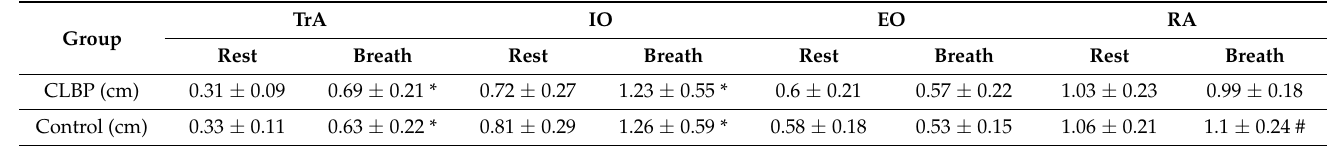
Table 2. Comparison of the muscle thickness between groups at rest and during